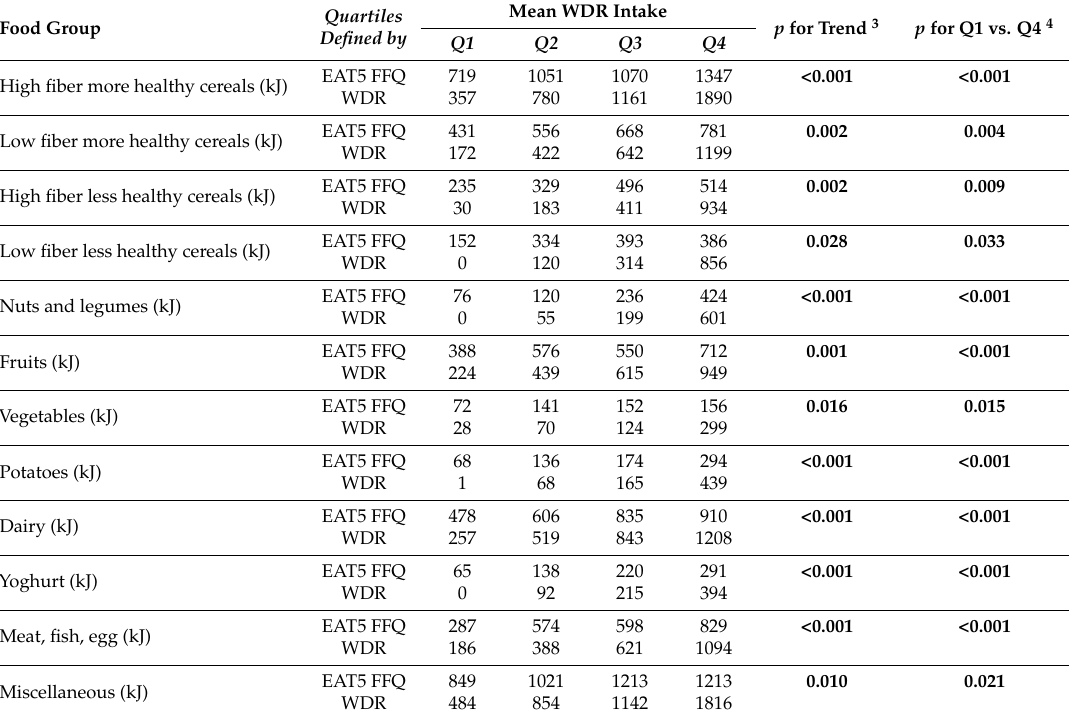
Table 8. Ability of the EAT5 FFQ to differentiate between quartiles of WDR food group intake (energy contribution), determined using actual values for surrogate categories ( n = 100) 1,2